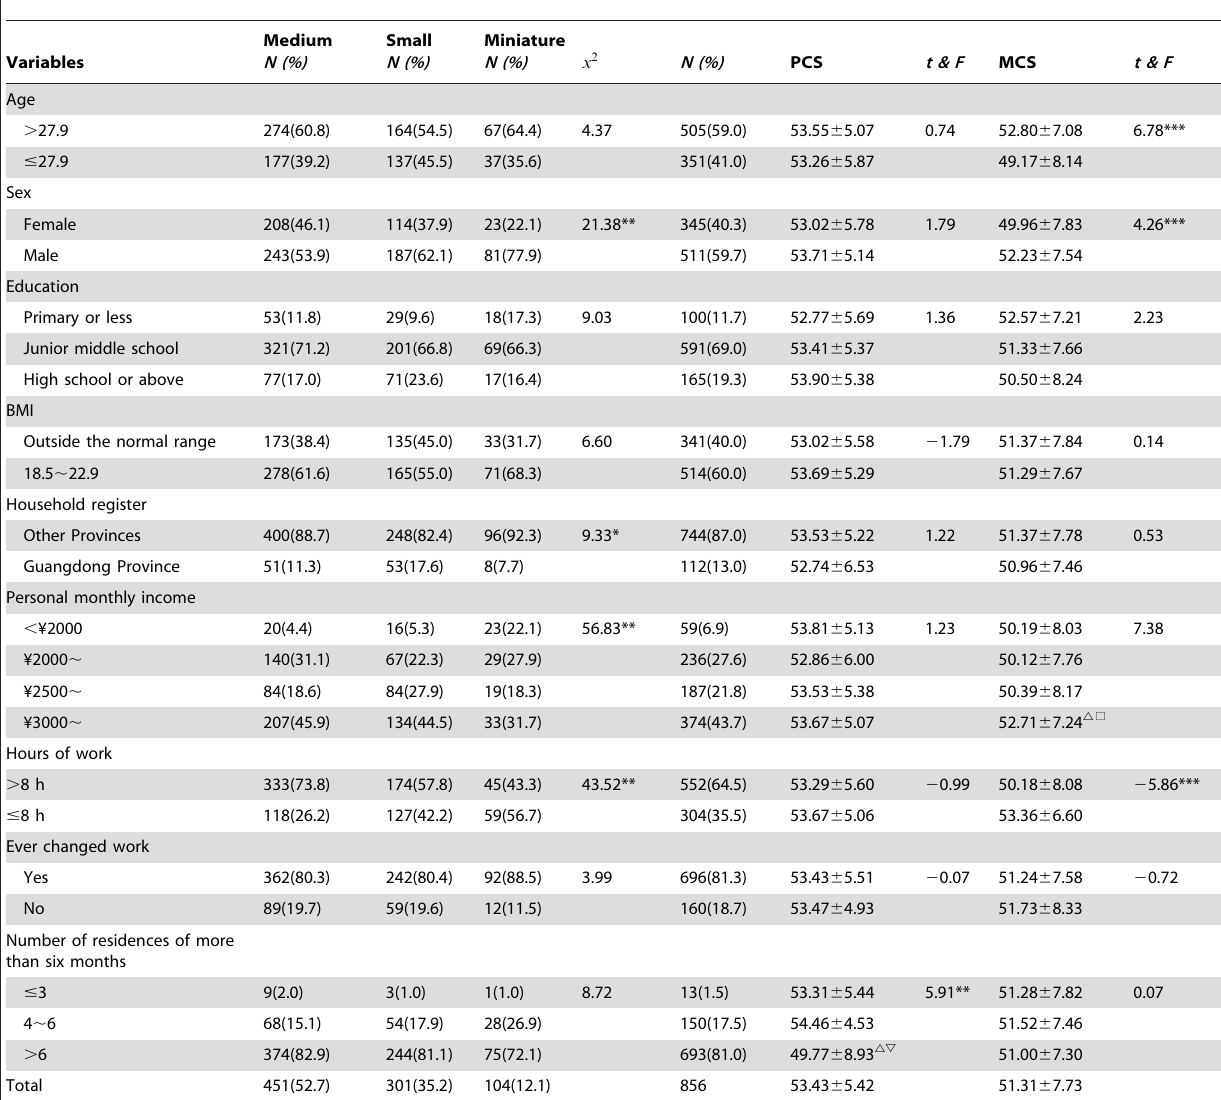
Table 3. Demographic characteristics and scores of Chinese migrants among different SMEs ( n =